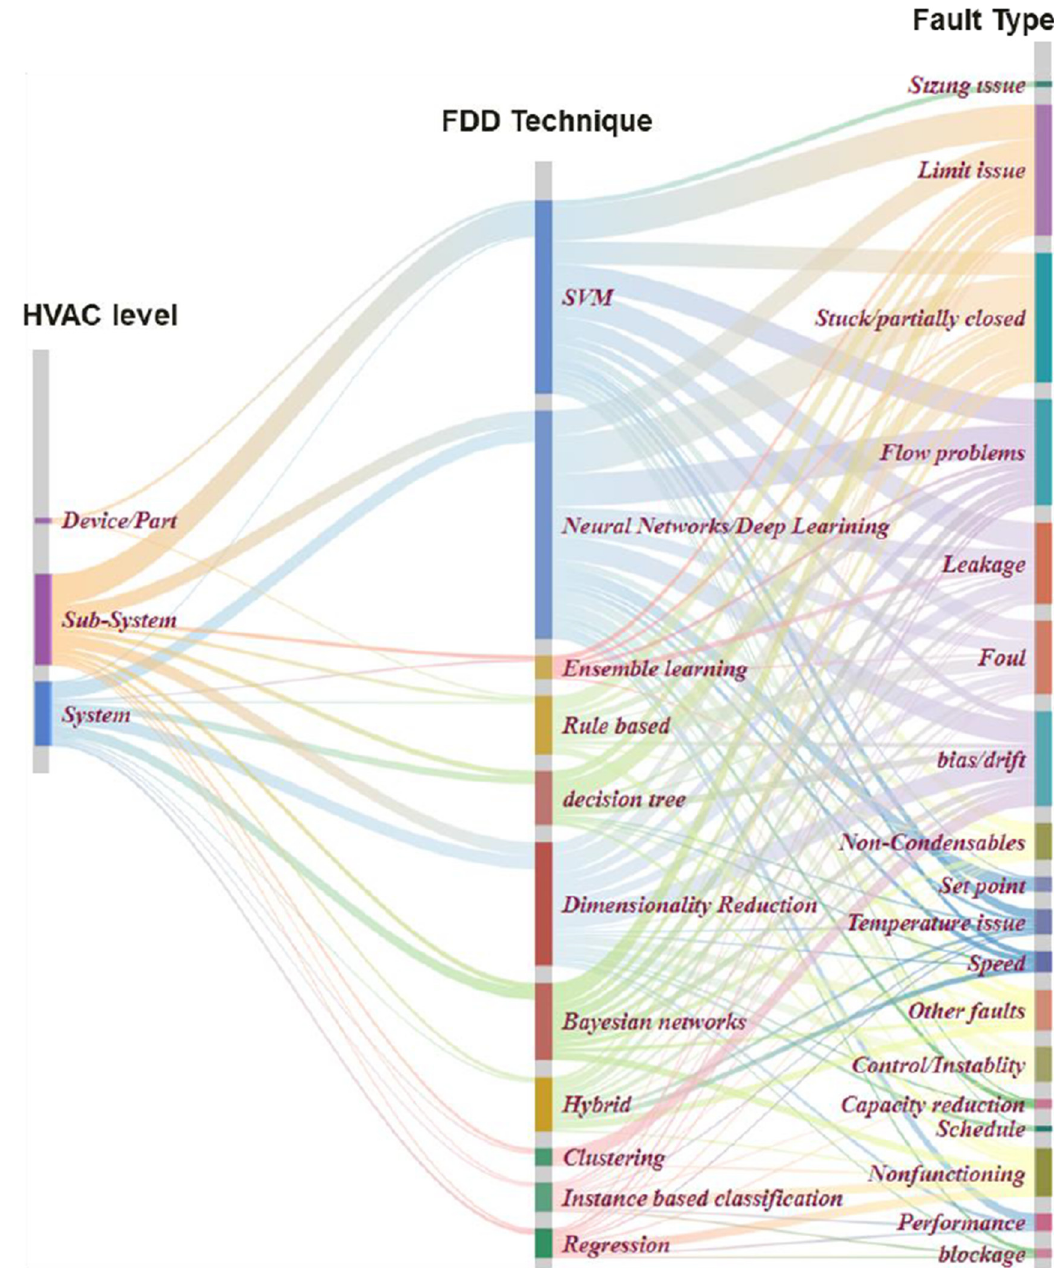
Figure 6. Relationship between system level, fault types, and FDD techniques used in the literature. Certain methods are utilized more often for specific fault types. For example, from a total of 68 ‘limit issue’ faults found in the literature, SVM (18 times), ANN (13), Bayesian networks (11), and ARM (11 times) have been used frequently to detect this type of fault. Nevertheless, for faults such as ‘stuck/partially closed’ and ‘flow problems’, neural networks and deep learning appear to be the most utilized methods. On the other hand, the clustering method has been mostly used for sensor-related faults such as ‘bias/drift’ and less frequently for ’non-functioning’ and never been used for ‘limit issue’ faults. The other approach for analyzing FDD techniques is to assess each method for the faults detected individually. It can be seen that Bayesian networks, hybrid methods, and ARM methods appear to be able to detect all of the six most common faults in the HVAC even though these methods are comparatively used to a lesser